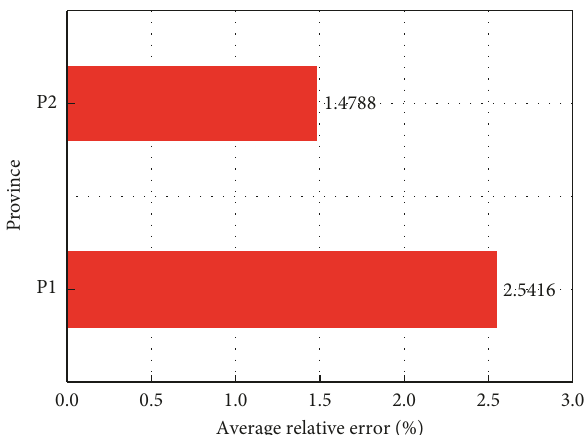
Figure 10: Average relative errors between the predicted and real public acceptance in two provinces.